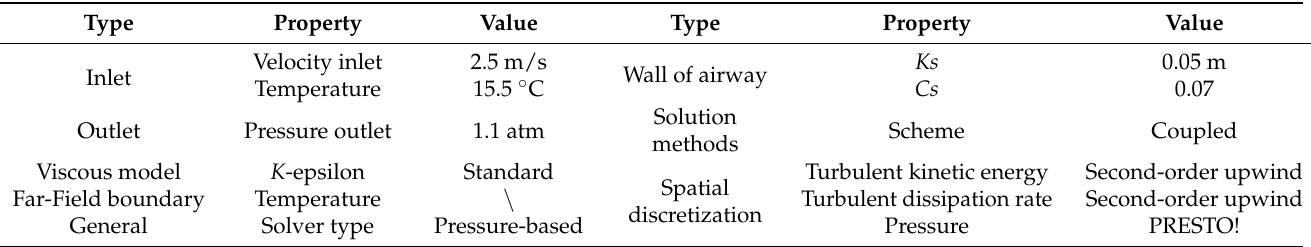
Table 3. Setting of simulation parameters.